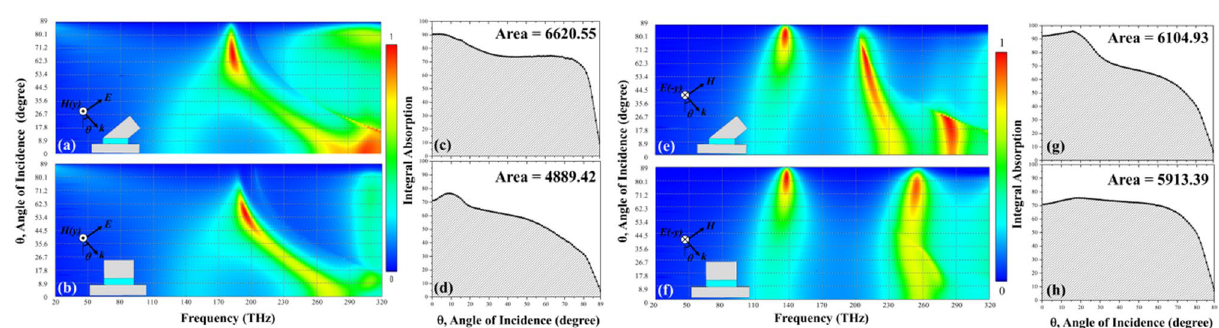
Figure 3. Absorbance diagram with respect to frequency and incident angles of the ( a , e ) SOFS and ( b , f ) planar MPAs for ( a , b ) TM and ( e , f ) TE modes. The integral absorbance plots with respect to the incident angle of the ( c , g ) SOFS and ( d , h ) planar MPAs for ( c , d ) TM and ( g , h ) TE modes. The integral areas of the SOFS and planar MPAs are 6620.55 and 4889.42 for TM mode and 6104.93 and 5913.93 for TE mode,